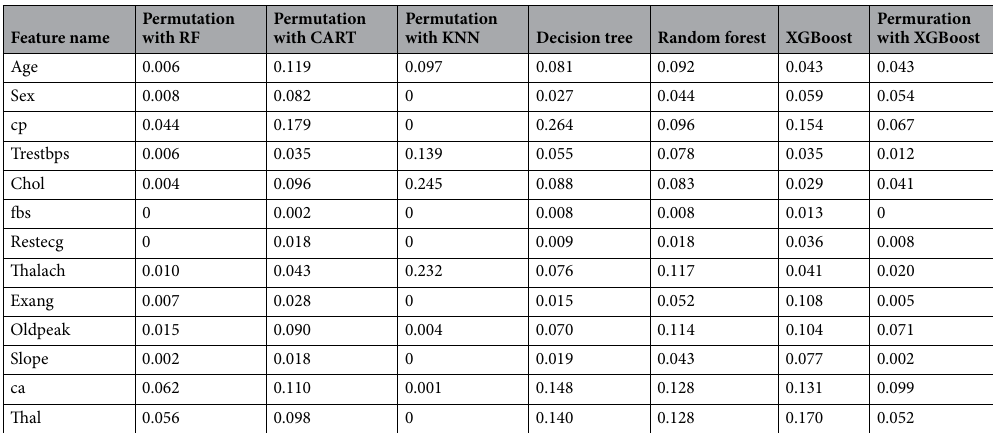
Table 5. Importance of features of the dataset.